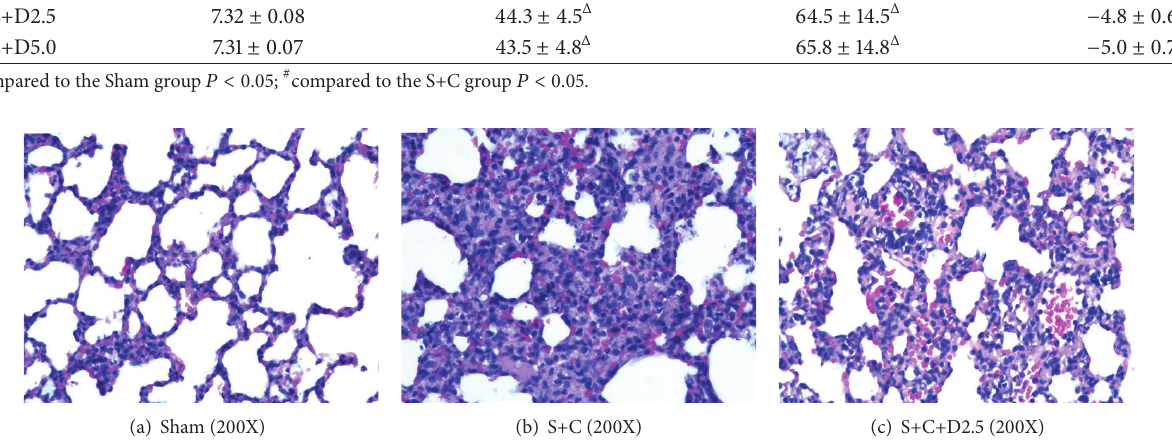
Figure 1: Histological sections from the lung were examined under the 200X power field. The IQA was the mean percentage of injured alveoli from the 200X power field. The AIT was examined under the 200X power field using the IMS image analysis system (ShenTeng Information Technology Co., Ltd, Shanghai). The AIT was the mean thickness of the alveoli.